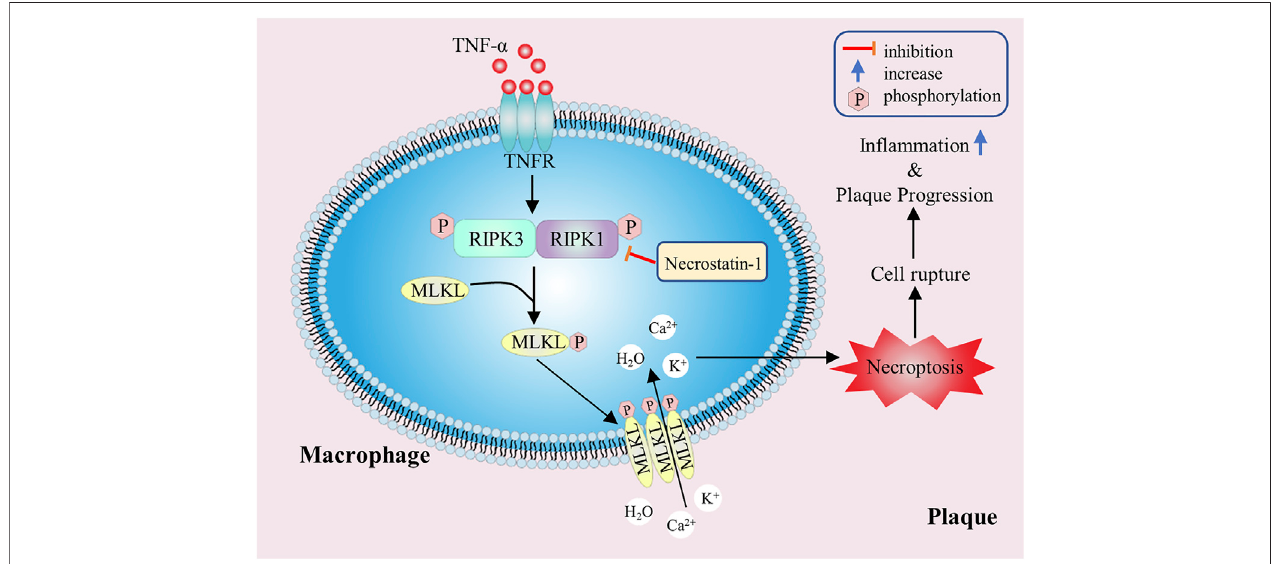
FIGURE 5 | The promoting effect of macrophage necroptosis on atherosclerosis. The RIPK1 and RIPK3 play a key regulatory role in necroptosis, and they can phosphorylate downstream MLKL. The activated MLKLs form selective ion channels, which eventually lead to cell membrane rupture, in fl ammatory factors release and plaque